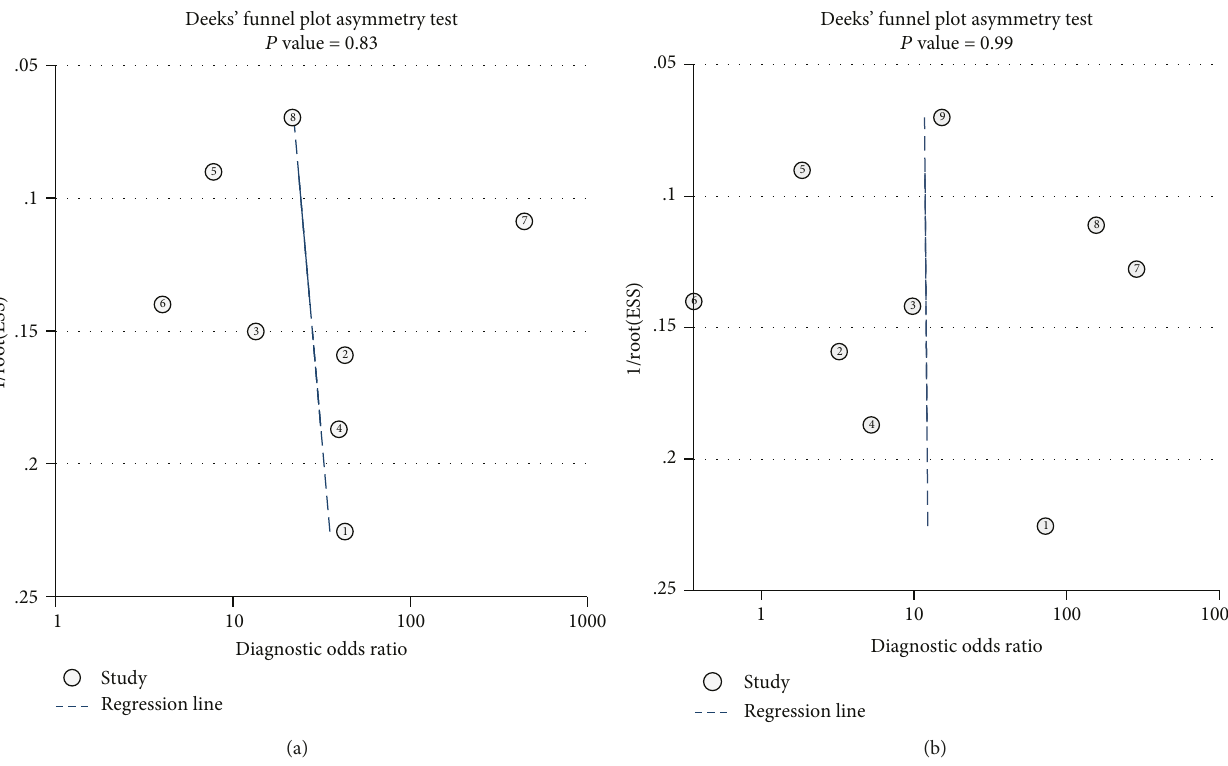
Figure 6: Funnel plot of included studies of anti-gp210 (a) and anti-sp100 (b). Deeks ’ test to detect funnel plot asymmetry in reviews of diagnostic studies was used to investigate publication bias. The almost vertical regression lines in the diagnostic odds ratios indicated there was no publication